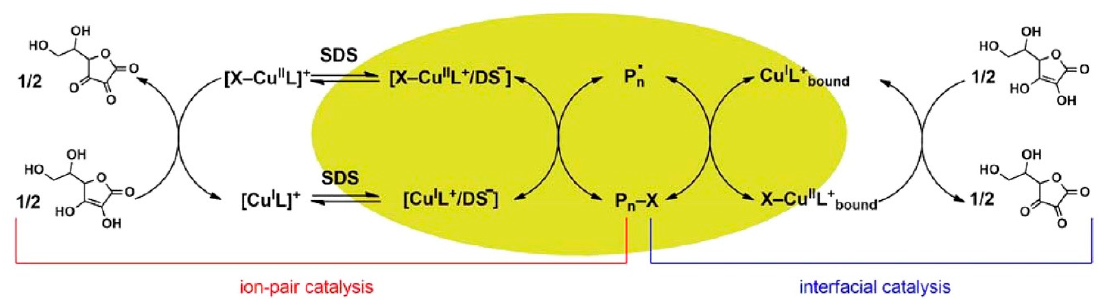
Scheme 4. Mechanism of ion-pair and interfacial catalysis in miniemulsion ARGET ATRP with ascorbic acid as a reducing agent. Reprinted with permission from reference [19], 2017, American Chemical